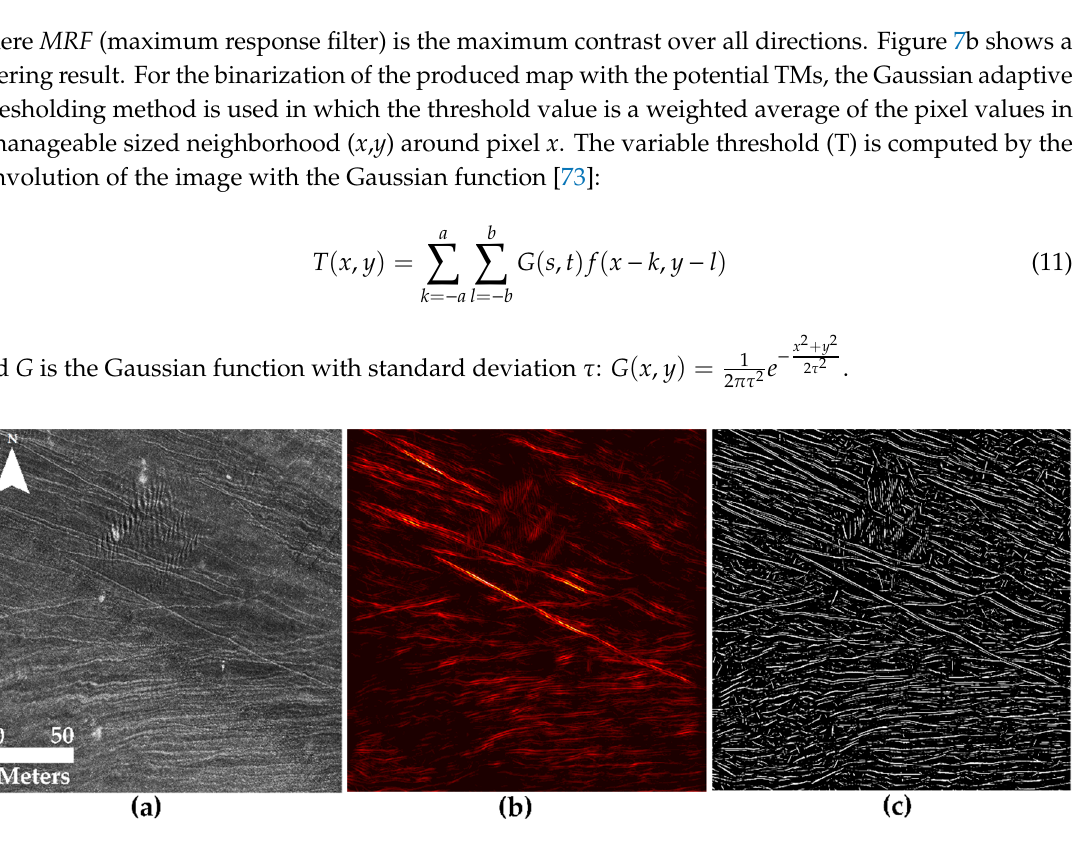
Figure 7. ( a ) The original SSS image depicting TMs of various orientations and contrasts, ( b ) the TME filter over the preprocessed image, ( c ) threshold segmentation over the TME filter’s